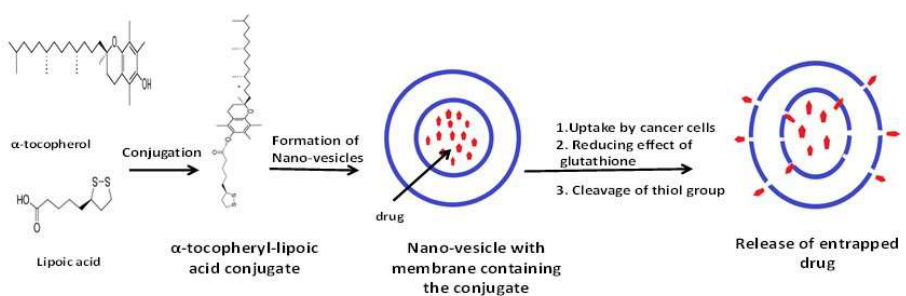
Figure 5. Schematic illustration of the proposed mechanism of action of thiol-triggered nano-vesicles using α-tocopherol-lipoic acid conjugate.